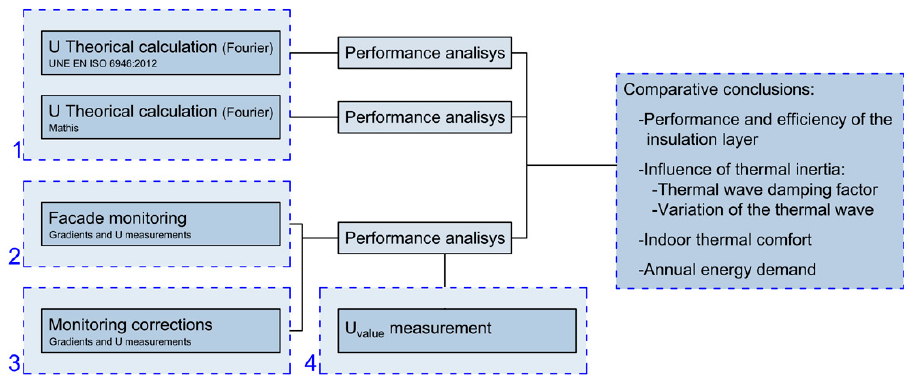
Figure 2. Design of the research methodology process.